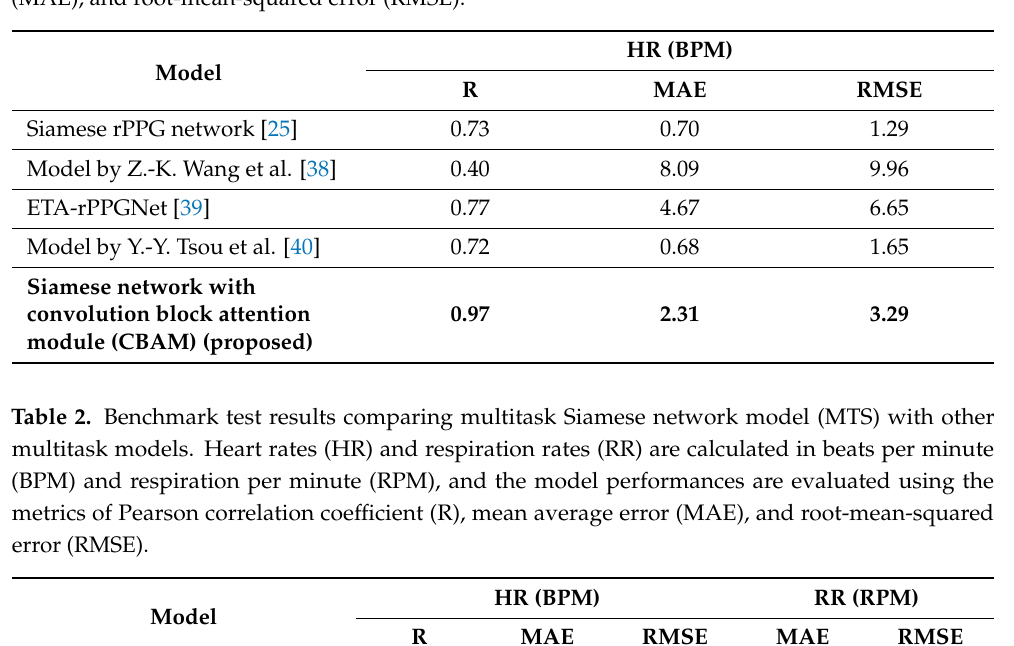
Table 1. Benchmark test results comparing our single-task model with the latest research results within five years. Heart rates (HR) are calculated in beats per minute (BPM), and the model perfor- mances are evaluated using the metrics of Pearson correlation coefficient (R), mean average error (MAE), and root-mean-squared error (RMSE).